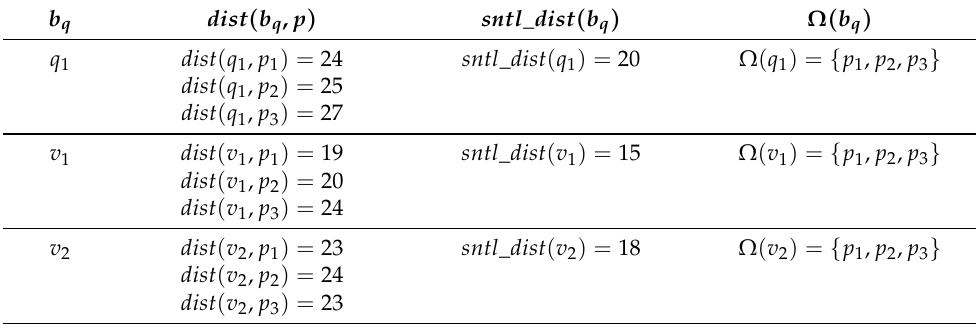
Table 5. Results of k FN queries at q 1 , v 1 , and v 2 and their sentinel distances.